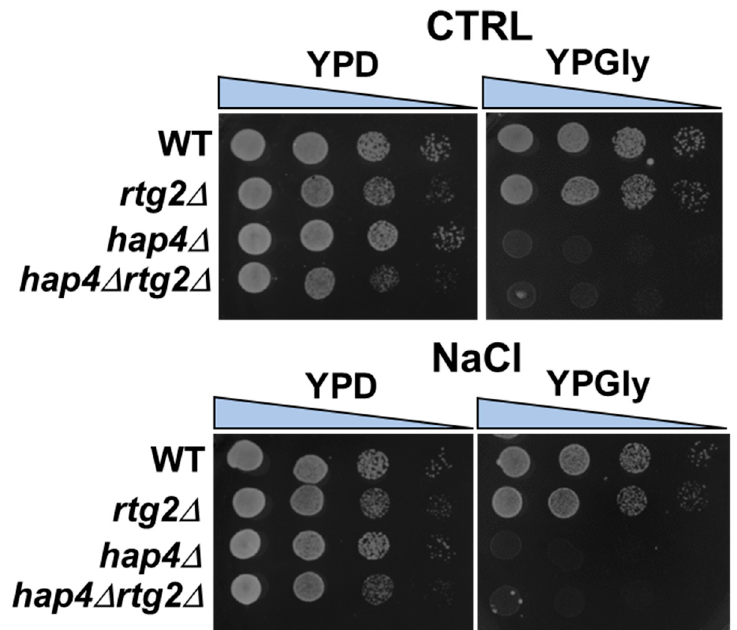
Figure 3. Mitochondrial respiratory competence upon NaCl stress. Wild type (WT) and mutant cells (rtg2 ∆ , hap4 ∆ , hap4 ∆ rtg2 ∆ ) grown overnight in YPD medium were diluted to 0.1 OD 600 in fresh liquid YPD with or without 0.8 M sodium chloride (NaCl). After 5 h, cells were diluted to 1 OD 600 and ten-fold serial dilutions were spotted on YPD and YPGly plates. Growth was scored after 2–5 days. The images reported are representative of three independent experiments.